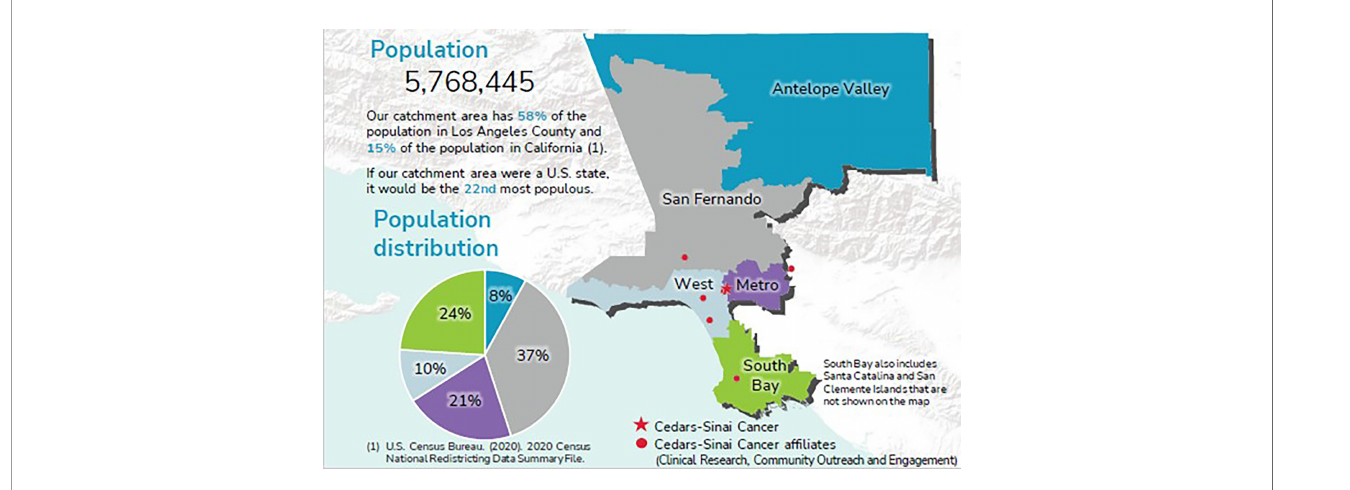
FIGURE 2 | Cedars Sinai Cancer catchment area.